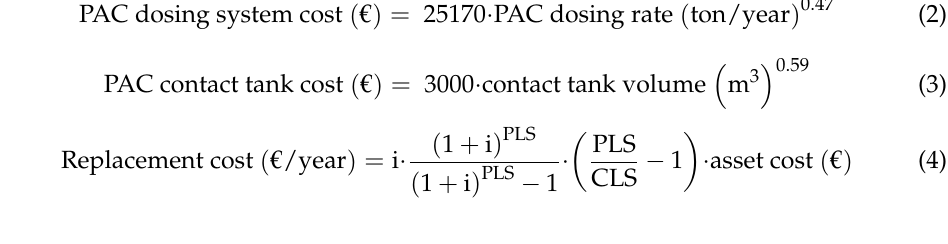
Table 6. Cost elements considered for the PAC